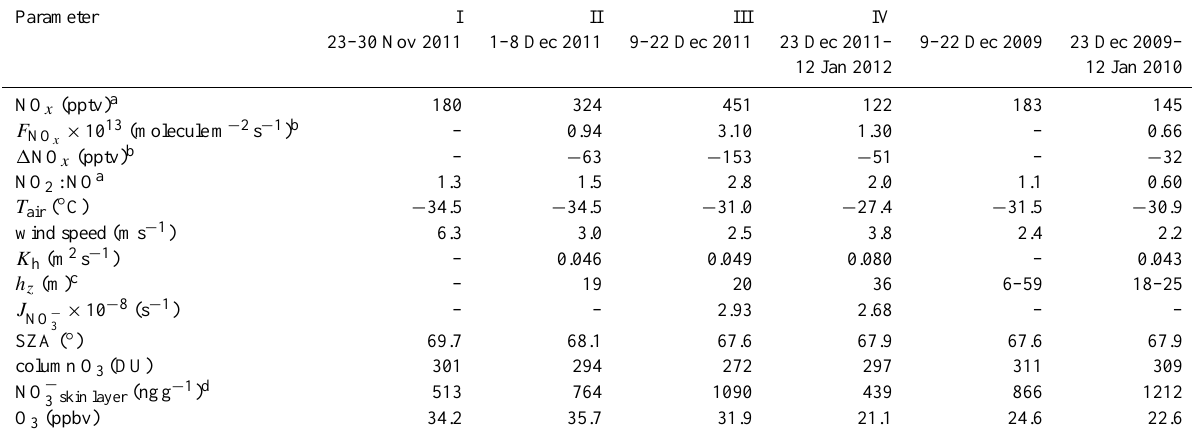
Table 2. Seasonal evolution of median NO x mixing ratios and flux along with relevant environmental parameters at Dome C in summer 2011–2012 (time periods I–IV highlighted in Figs. 1 and 7) and comparison to summer 2009–2010 (from Frey et al., 2013). Parameter I